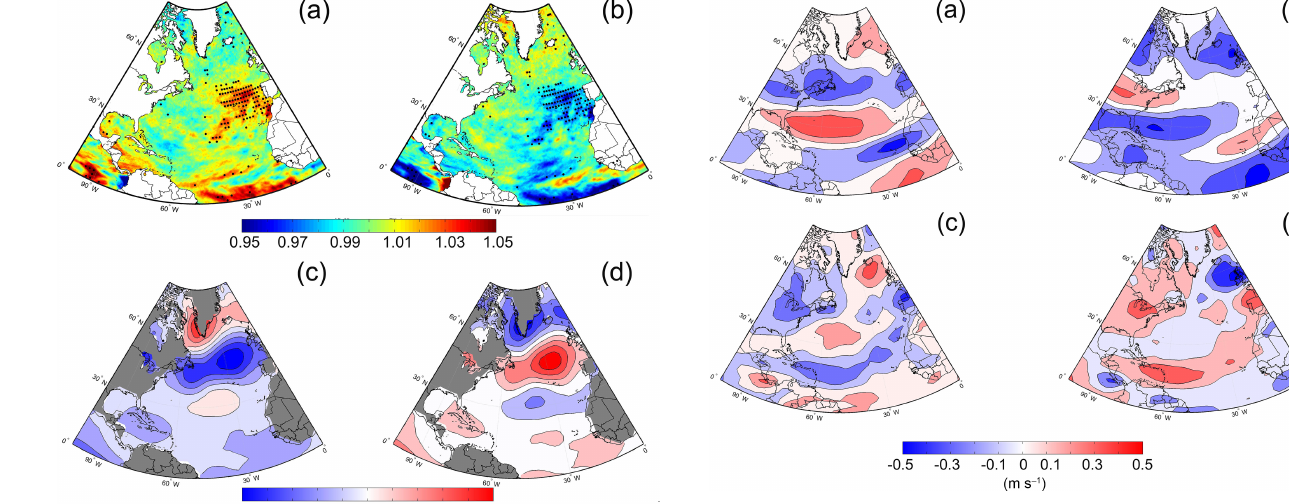
Figure 5. Wind speed anomalies in the Atlantic for winter (JFM). (a, b) and (c, d) correspond to years with positive/negative summer (JAS) FTLE anomalies. Upper and lower maps correspond to 200 and 850hPa levels,